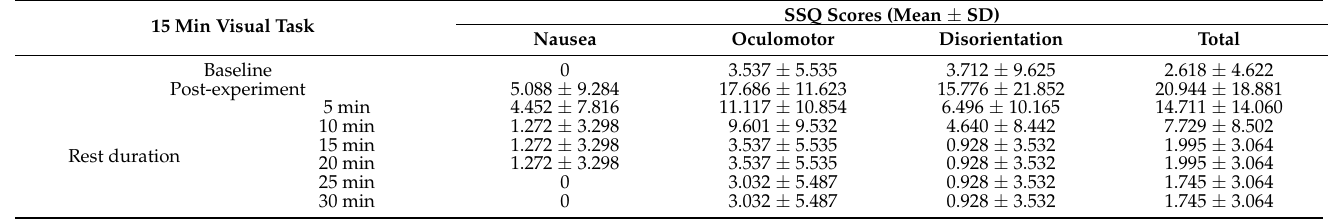
Table 4. Means and standard deviation results for SSQ scores for 15 min visual task baseline, post- experiment, and rest time.